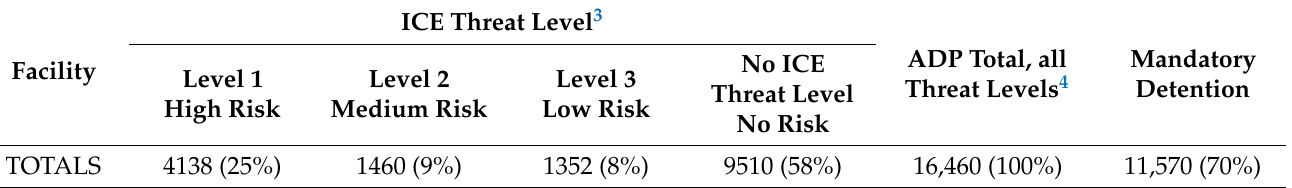
Table 1. Average Daily Threat Level (ICE